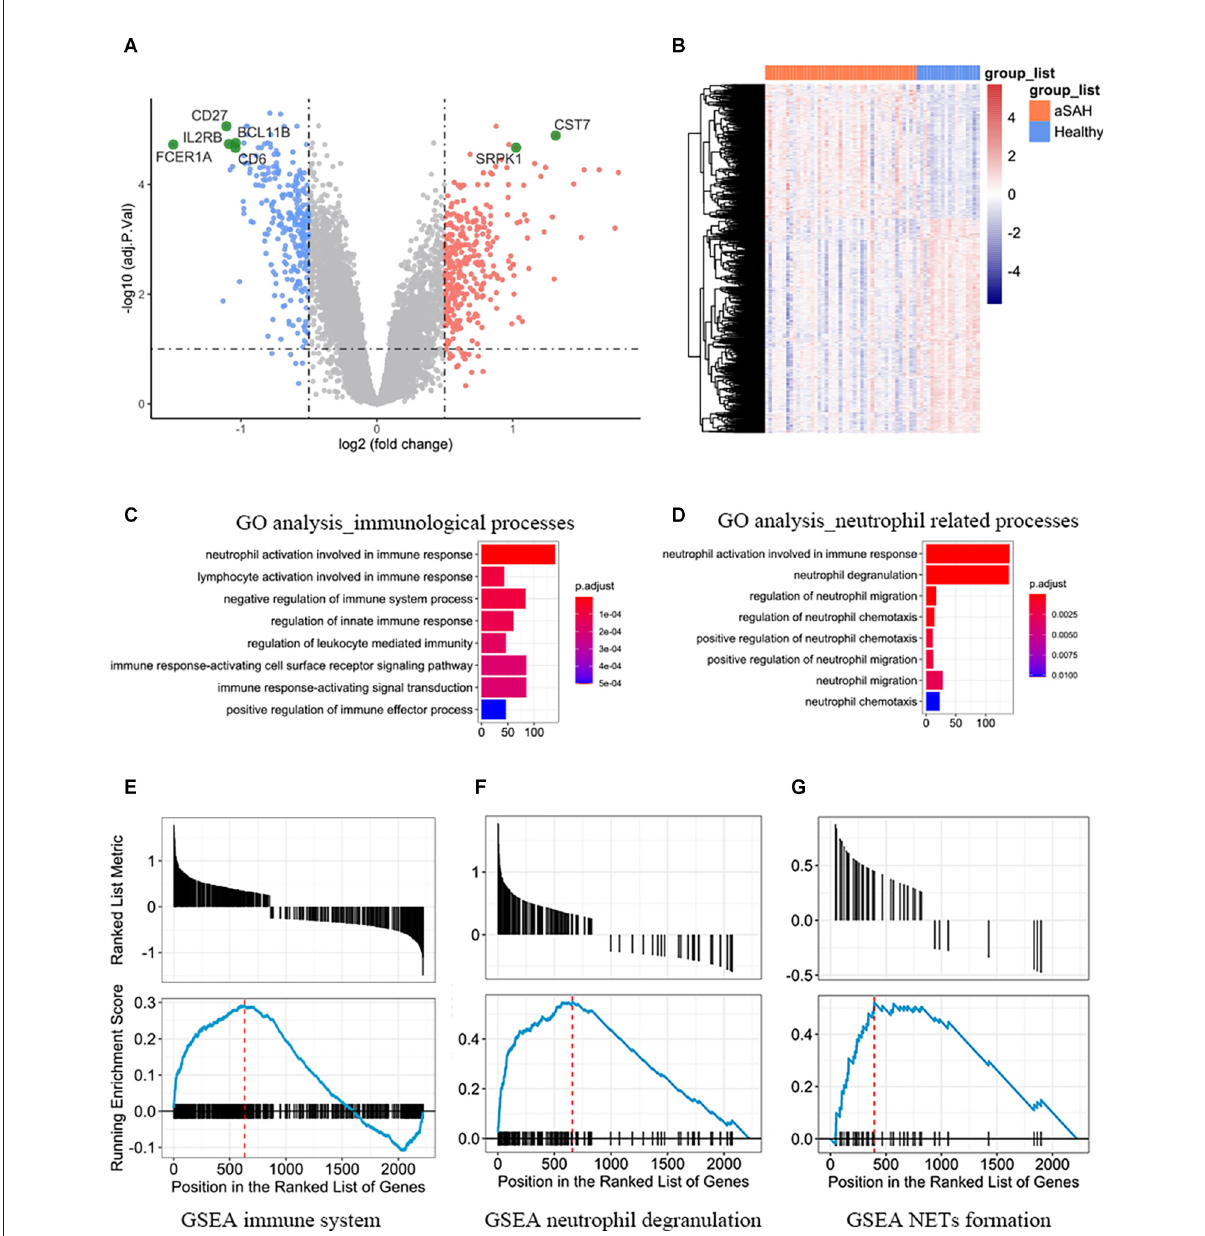
FIGURE1 (A) Volcano plot and (B) heatmap showing the expression profiles between aSAH and control groups. (C) The top eight functions associated with immunological processes between aSAH and healthy samples. (D) The top eight functions associated with neutrophil. (E–G) Representative enriched pathways of GSEA. Each graph represents immune system, neutrophil degranulation, and neutrophil extracellular traps (NETs)